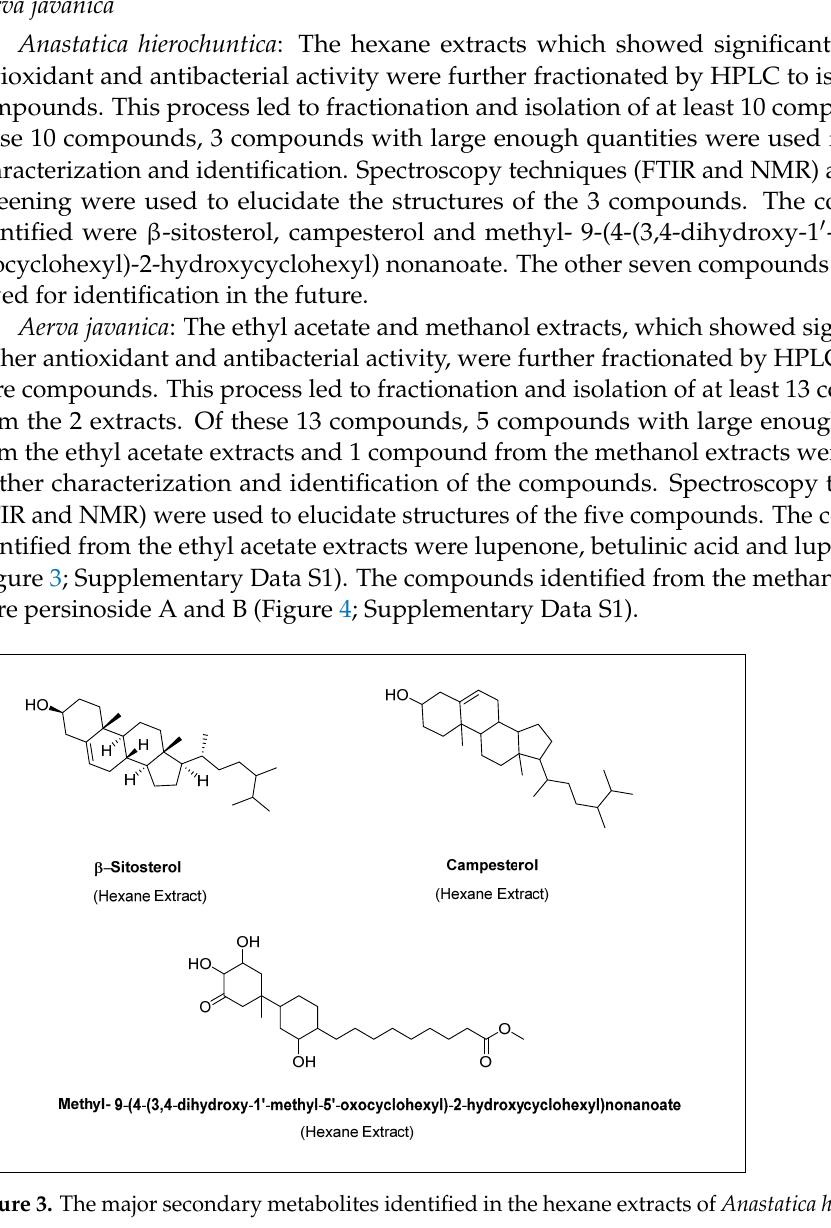
Figure 4. The major secondary metabolites identified in the ethyl acetate and methanol extracts of Aerva javanica. 2.5. Antibacterial and Antifungal Activity of Isolated Compounds for Both the Plants Antibacterial action of isolated compounds β‐ sitosterol, campesterol and methyl ‐ 9 ‐ (4 ‐ (3,4 ‐ dihydroxy ‐ 1 ′‐ methyl ‐ 5 ′‐ oxocyclohexyl) ‐ 2 ‐ hydroxycyclohexyl)nonanoate